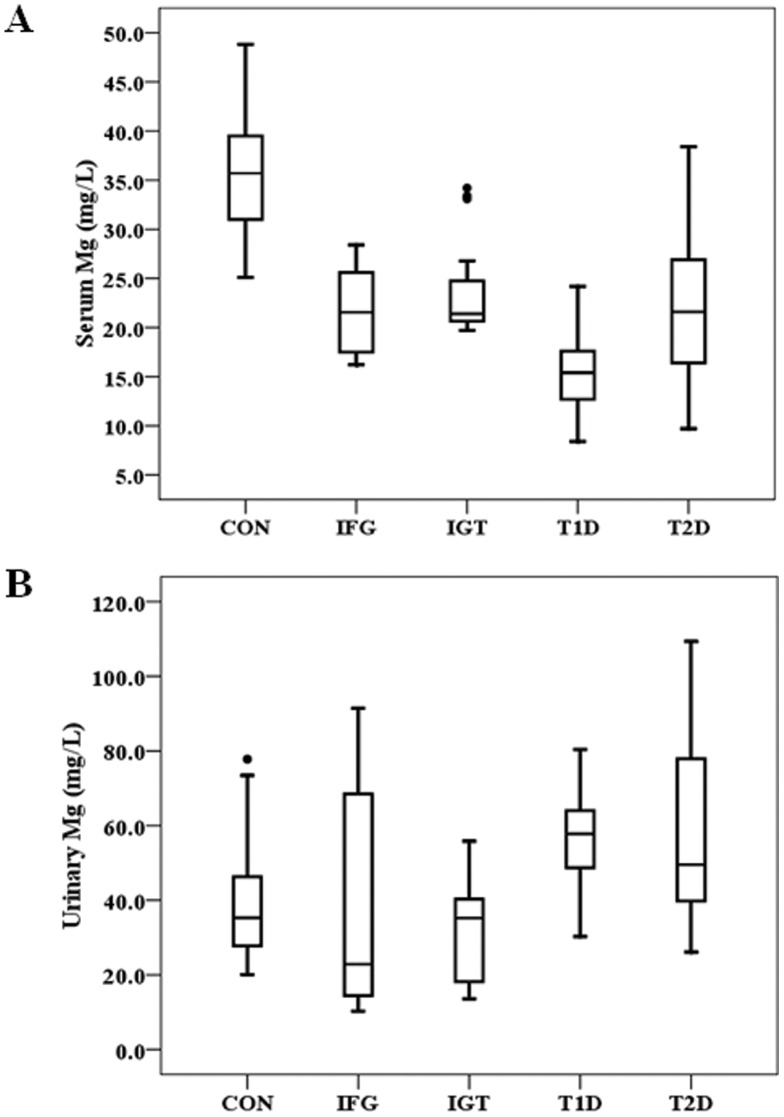
Levels of Mg in healthy control, IFG, IGT, T1D and T2D groups.Boxplots display the extremes, the upper and lower quartiles, and the median of the maximum difference in healthy control, IFG, IGT, T1D and T2D groups. The median for each dataset is indicated by the centerline, and the first and third quartiles are represented by the edges of the area, which is known as the inter-quartile range (IQR). The extreme values (within 1.5 times of the IQR from the upper or lower quartile) are represented by the ends of the lines extending from the IQR. Points at a greater distance from the median than 1.5 times of the IQR are plotted individually as dots. P value of serum Mg levels was <0.0001 between healthy control group and IFG, IGT, T1D and T2D groups (Fig. 1A). P value of urinary Mg levels was <0.0001 between healthy control group and T1D and T2D groups (Fig. 1B).